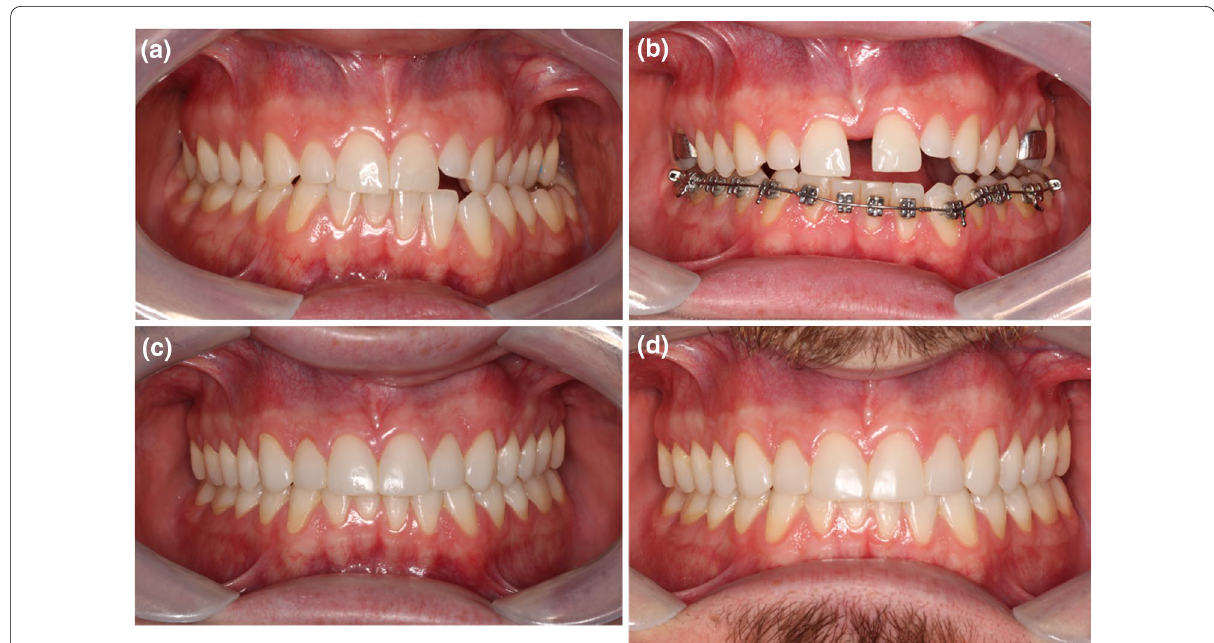
Fig. 3 A 24‑year old male patient with a maxillary transverse deficiency, a posterior cross‑bite and OSA (AHI 19.7); B The malocclusion after 8.5 mm of palatal expansion (AHI 4.8); C just after the brackets debonding and restorative composites; D 2‑years retention